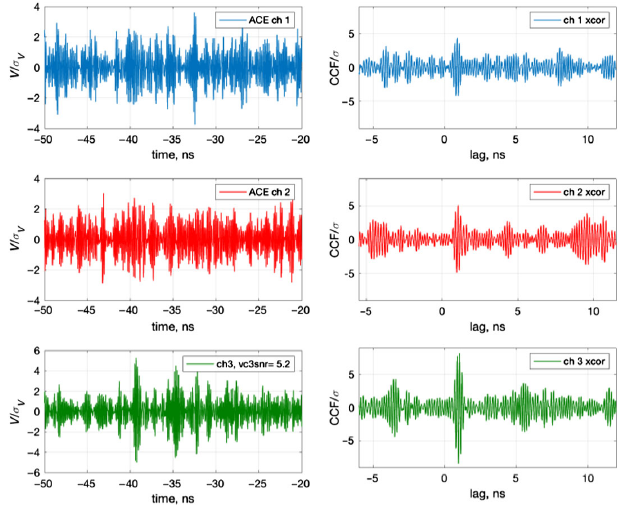
FIG. 9. Left: raw waveforms for a single event in run 312. Right: cross-correlation functions (CCF) with the signal tem- plates. Slight offsets in the template reference time account for the lag differences in the